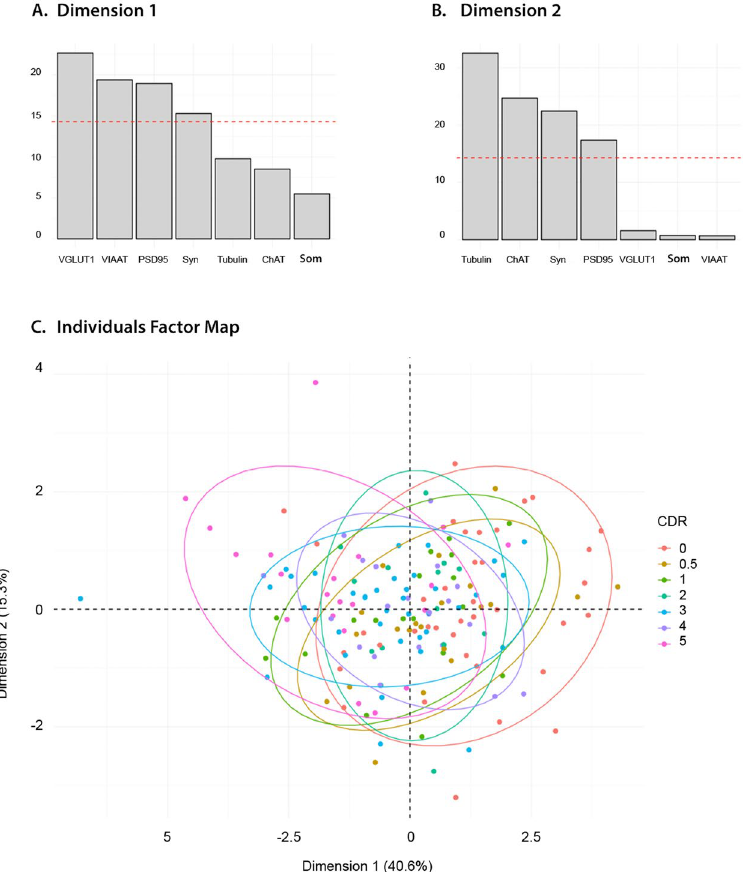
Figure 9. Principal component analysis. The contribution of the variables to the first ( A ) and second ( B ) dimensions. VGLUT1 was the major contributor to the first dimension (23%) and α -tubulin for the second dimension (32%). The individual factor map ( C ) illustrates the principal component analysis. No clear relationship emerged between biological markers represented by the 2 dimensions and the CDR